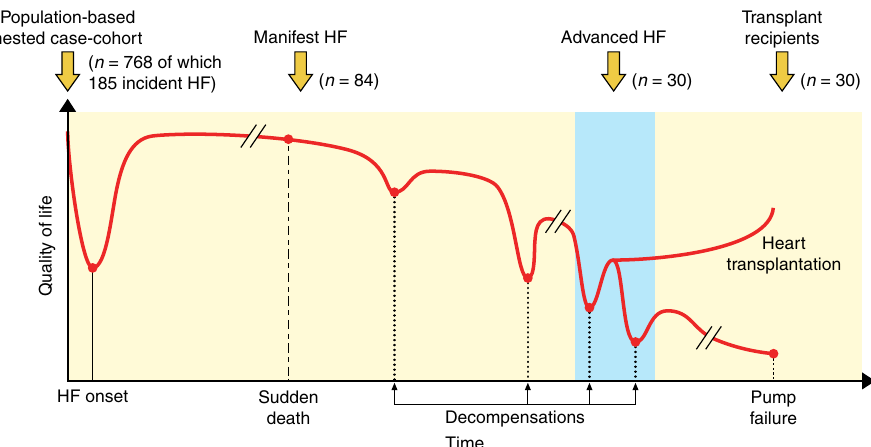
Fig. 1 Sampling of study cohorts from different stages of heart failure. Schematic representation of the natural history of heart failure (HF) progression, from the initial timepoint of disease onset through a gradual decline with increasing episodes of worsening typically necessitating in-hospital care (decompensations) towards terminal pump failure. Cohorts for the current study were obtained from four stages: before disease onset (population-based cohort), during manifest HF, and serially in advanced HF before and after heart transplantation. Proteomic pro fi les in subjects with incident HF from the population-based cohort were compared to subjects without incident HF. Manifest HF patients were compared to the population-based cohort. Samples from heart transplant recipients were compared to the corresponding samples from the same patient before